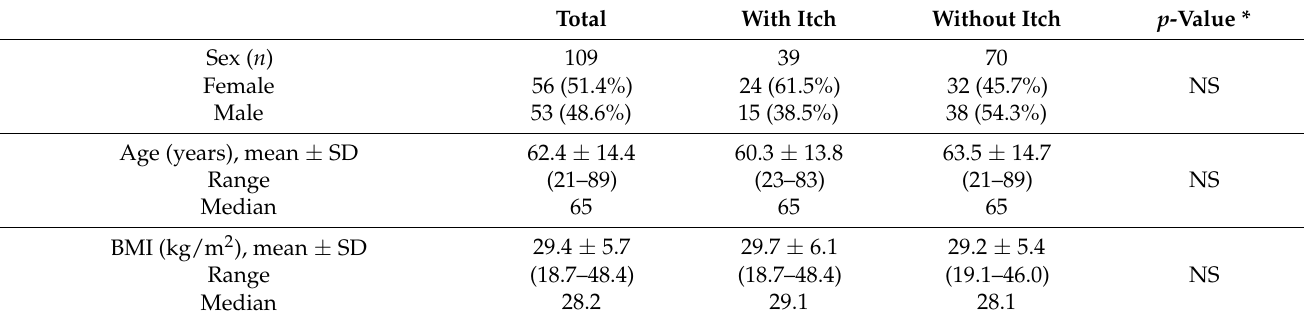
Table 1. Characteristics of the studied